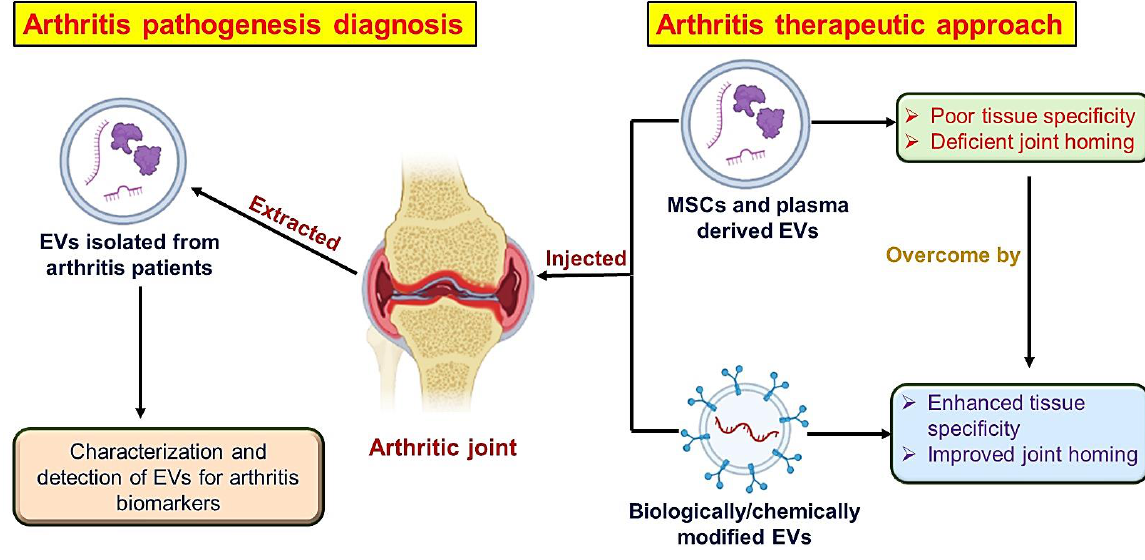
Figure 4. Role of extracellular vesicles in the diagnosis and treatment of arthritis.